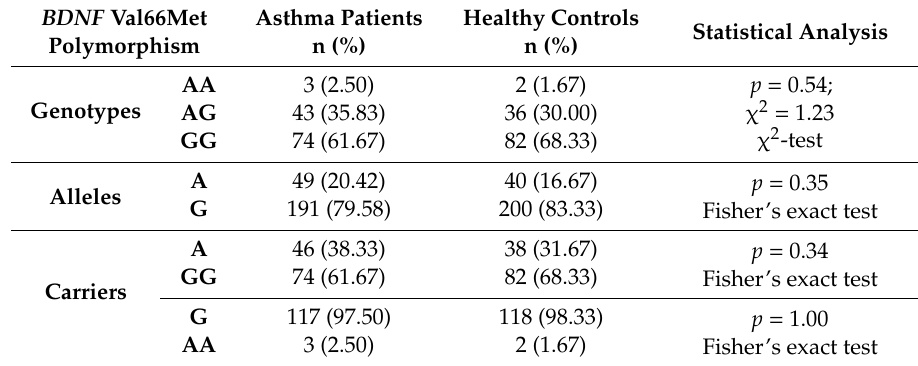
Table 2. Distribution of genotypes, alleles and carriers of BDNF Val66Met polymorphism in asthma patients and healthy subjects.